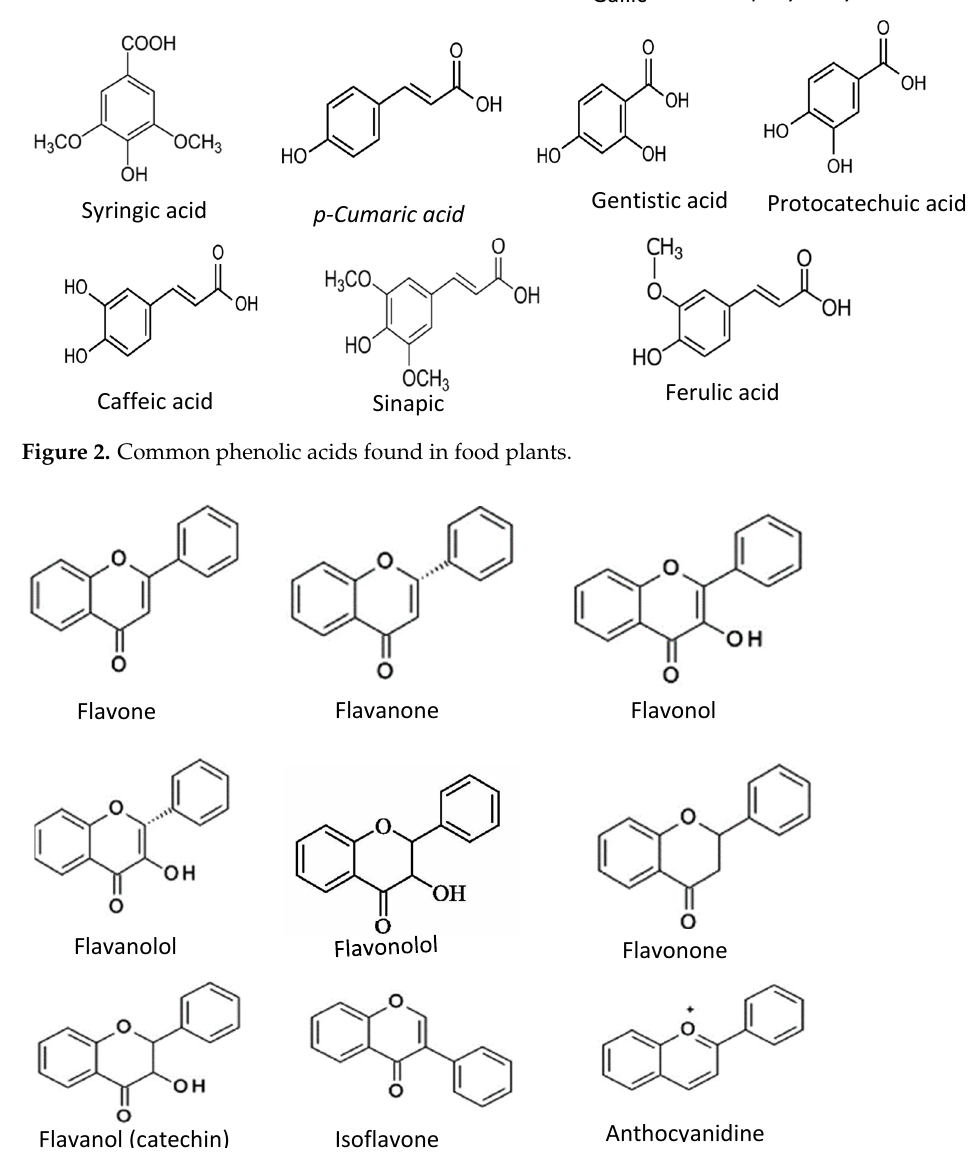
Figure 2. Common phenolic acids found in food plants.